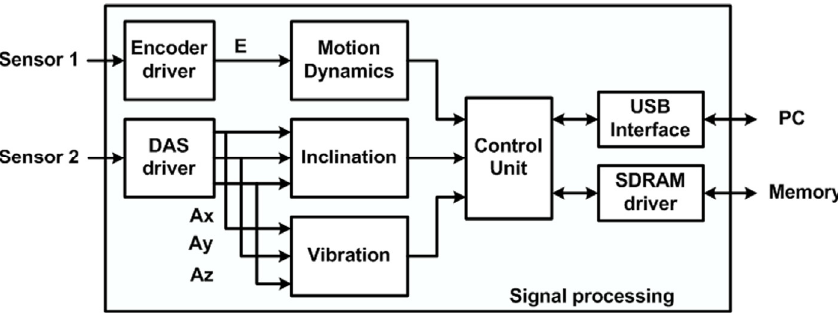
Figure 4. Smart sensor methodology showing the main blocks in the